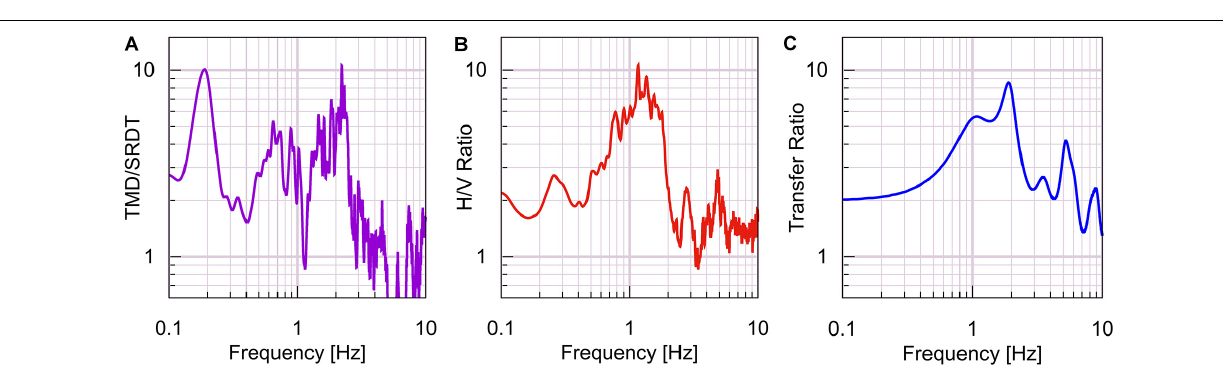
Frontiers in Built Environment |